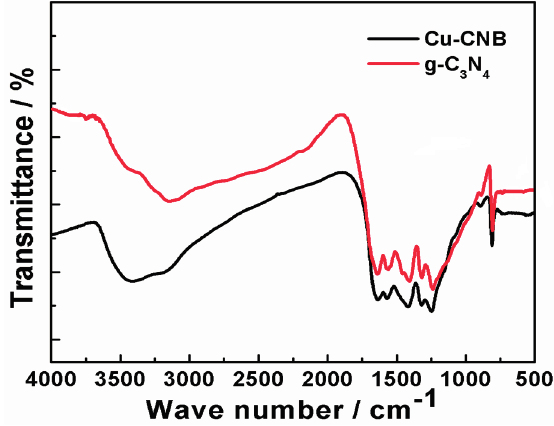
Figure 4. The FT-IR spectra of g-C 3 N 4 and